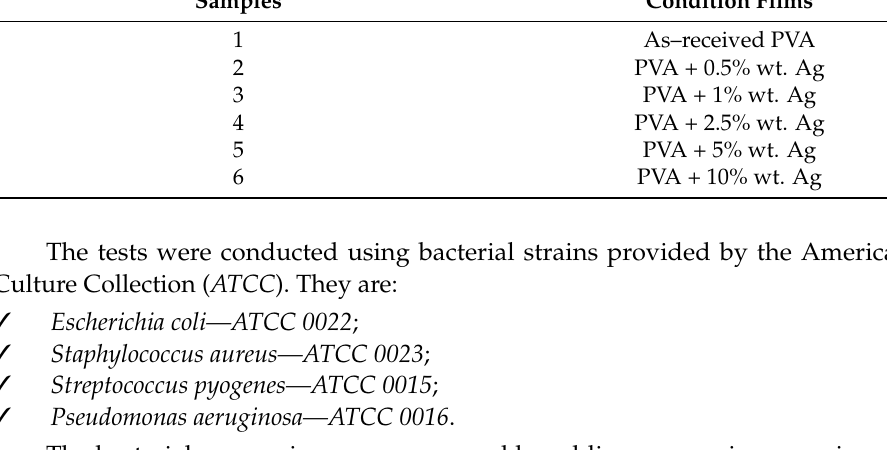
Table 4. Samples used to assess the antimicrobial activity of polymeric films.